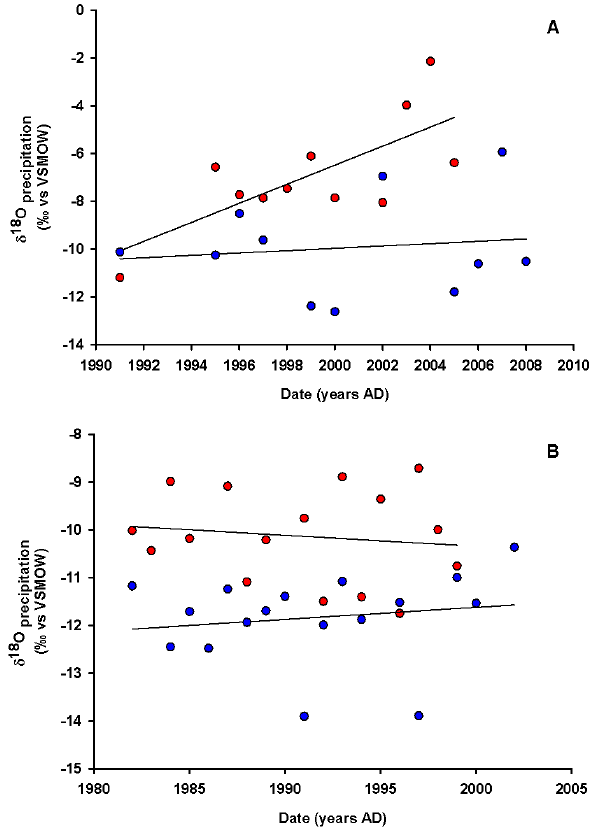
Fig. 5. Comparison of seasonal trends in the mean amount-weighted δ 18 O-values in precipitation for Punta Arenas (A) and Ushuaia (B) . For Punta Arenas, red dots=DJF ( r 2 =0.53; P < 0 . 05); blue dots=JJA ( r 2 = 0 . 01; P (cid:29) 0 . 1). For Ushuaia, red dots=DJF ( r 2 = 0 . 02; P (cid:29) 0 . 1) ; blue dots=JJA ( r 2 = 0 . 03; P > 0 . 1).